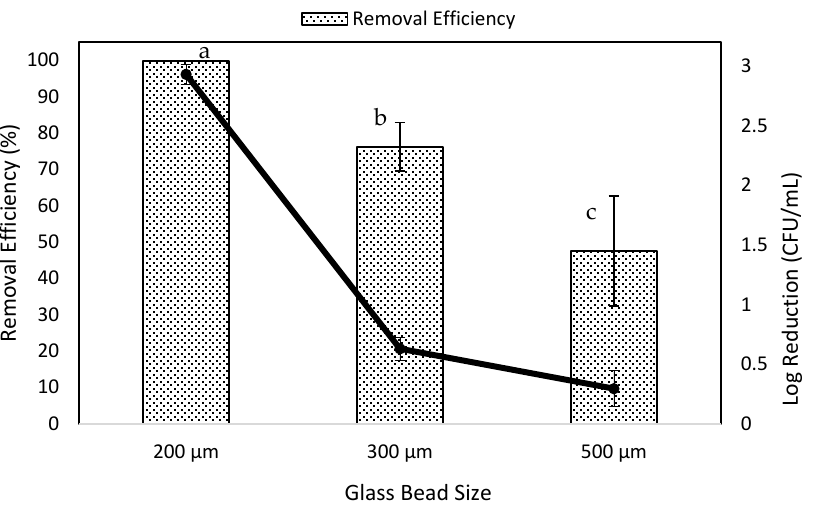
Figure 11. Comparison of the average removal efficiency and log reduction among three different bead sizes. Different letters indicate significant differences among the different bead sizes ( p < 0.05).